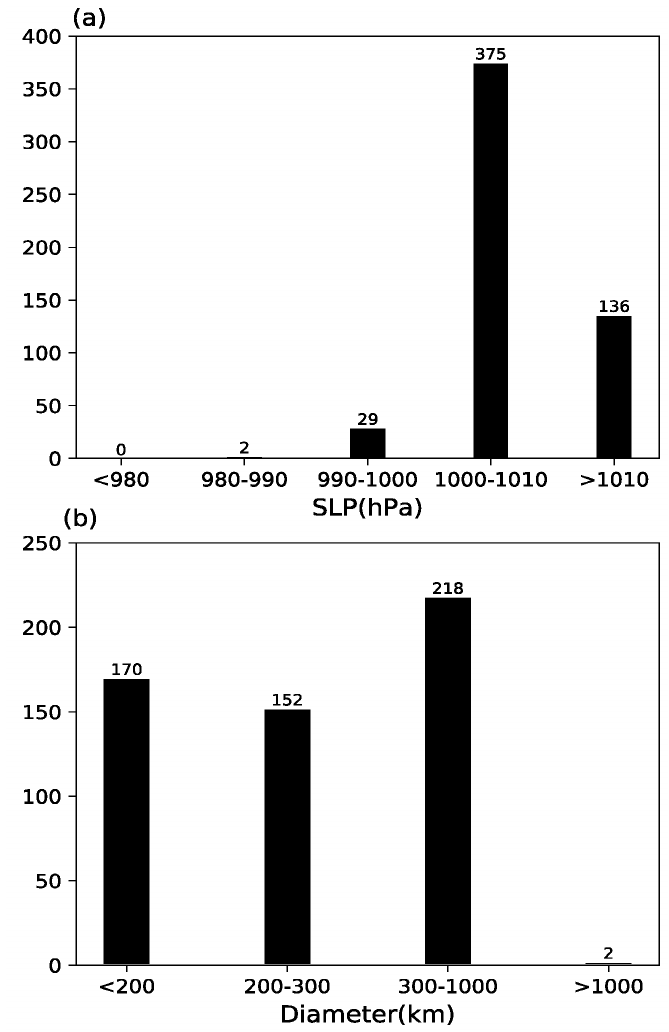
Figure 7. ( a ) SLP and ( b ) diameter of ICs with lifetimes shorter than 18 h.